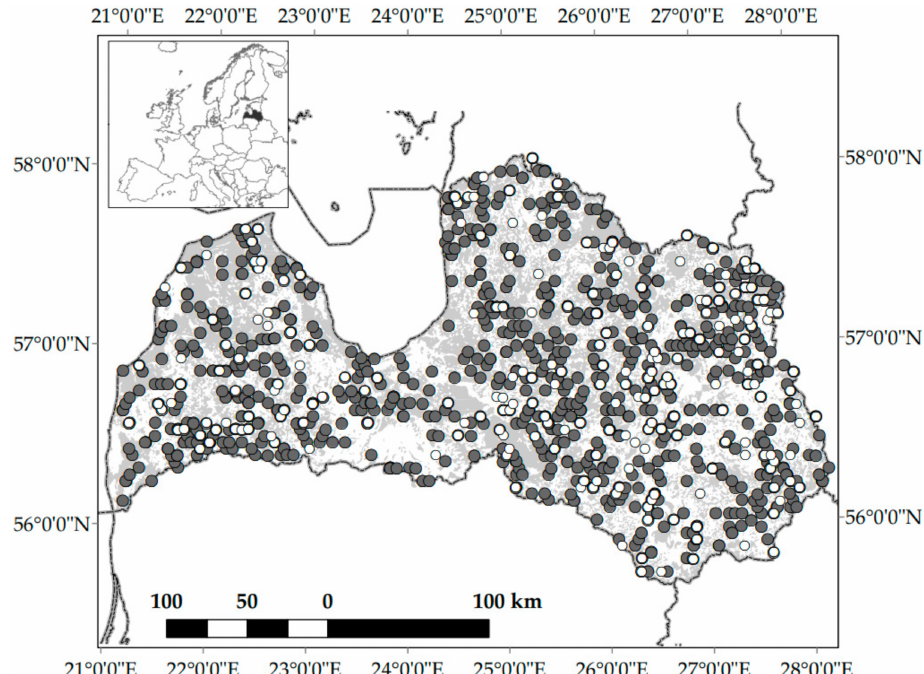
Figure 1. The location of the National Forest Inventory sample plots used for the analysis of wind- induced damage occurrence (dark circles) and analysis of stem assortment recovery (clear circles). Grey background coloring indicates forest